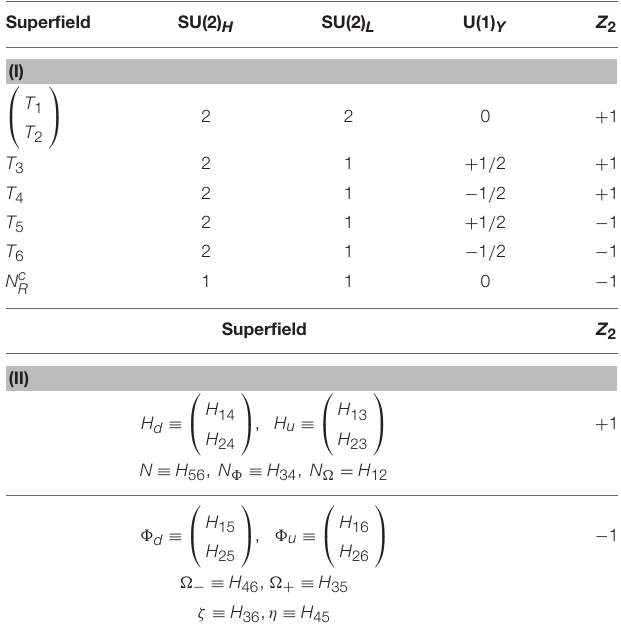
U(1) Y ) and the Z 2 parity. (II) The field ×